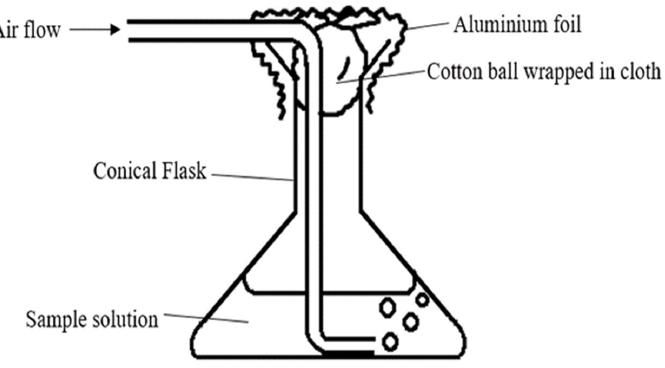
Figure 1. Setup of each conical flask.